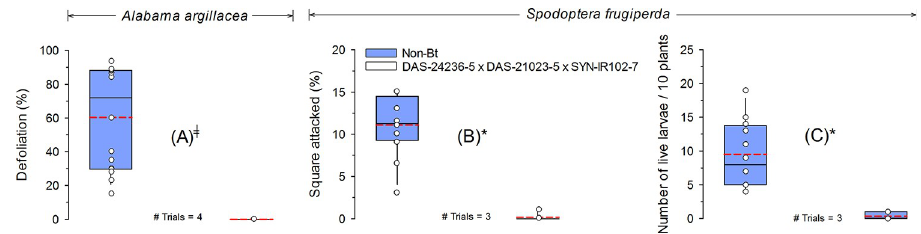
Fig 3. Efficacy of Bt cotton technology with events DAS-21023-5 × DAS-24236-5 × SYN-IR102-7 against natural infestations of Alabama argillacea or Spodoptera frugiperda . The dashed (red) and solid (black) lines in boxplots present the mean and median across trials, respectively. Dot markers indicate values from individual trials. ╪ Statistical test not applied due to a numerical difference sufficiently large enough to declare a difference between treatments means. � Significant difference between non- Bt and Bt cotton technology by F -test ( α =